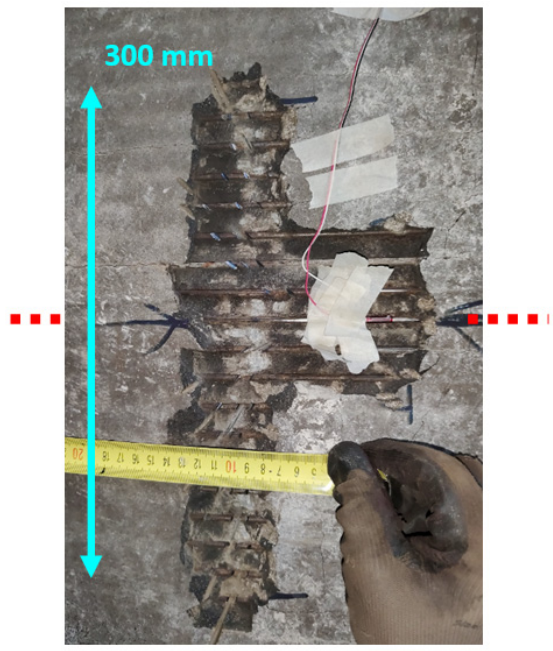
Figure 21. External façade of the pipe at the East cross-section before the 3EB test.